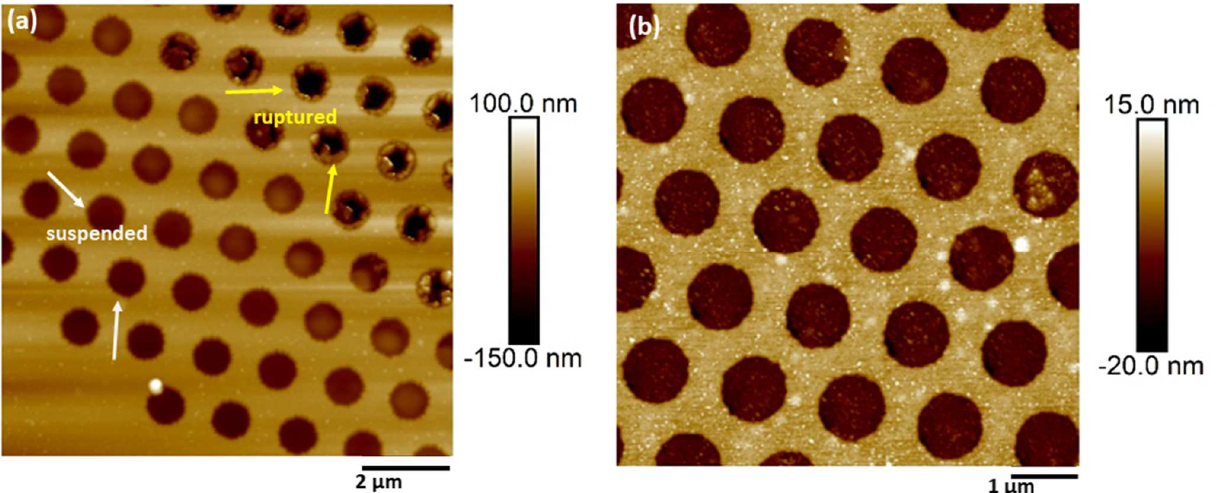
Figure 4. Freely suspended CNM membranes. The topography of suspended ( a ) Active layer of a CNM transferred from a composite membrane and ( b ) PVBP CNM.